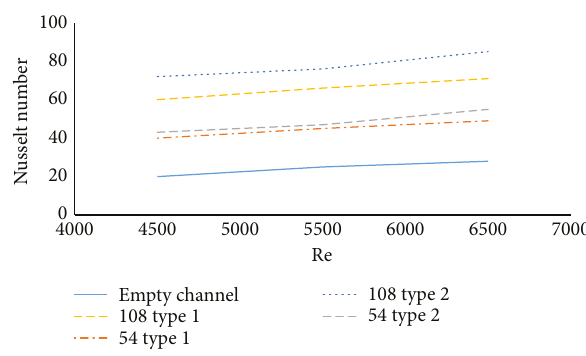
Figure 11: Nusselt representations of di ff erent fi n con fi gurations in the photovoltaic system.